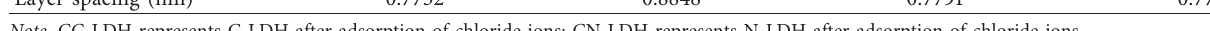
Table 6: Layer spacing of C-LDH and N-LDH before and after adsorption of chloride ions.